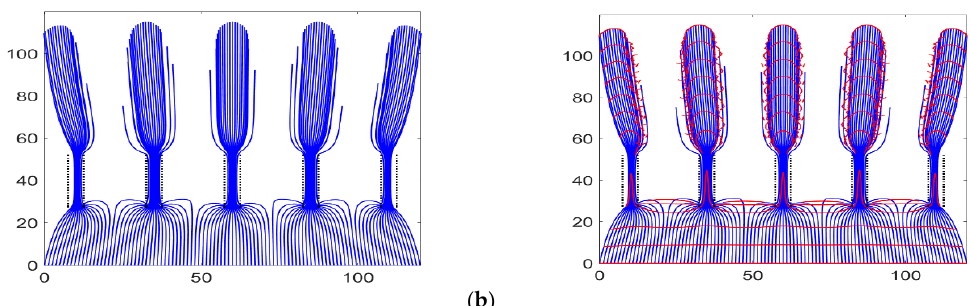
Figure 6. ( a ) REV model showing the effect of a natural fracture (NF) porosity of 100% (open fracture) in a reservoir space of 5% porosity with no permeability change. ( b ) Natural fractures with increased strength of 1000 ft 4 /year. Streamlines in blue (left side) and TOFC in red (right side). Natural fractures in black.